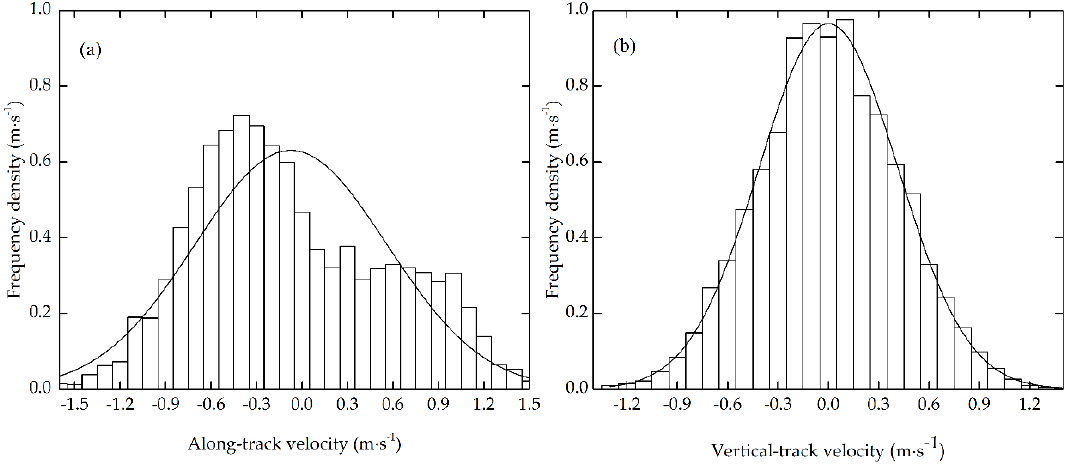
Figure 2. Distributions of ( a ) along-track velocity and ( b ) vertical-track velocity of the icebreaker during the ramming process compared to normal distributions (solid lines). Data are from the shipboard recorded velocity during the Antarctic expedition of the research vessel Polarstern in 2006.